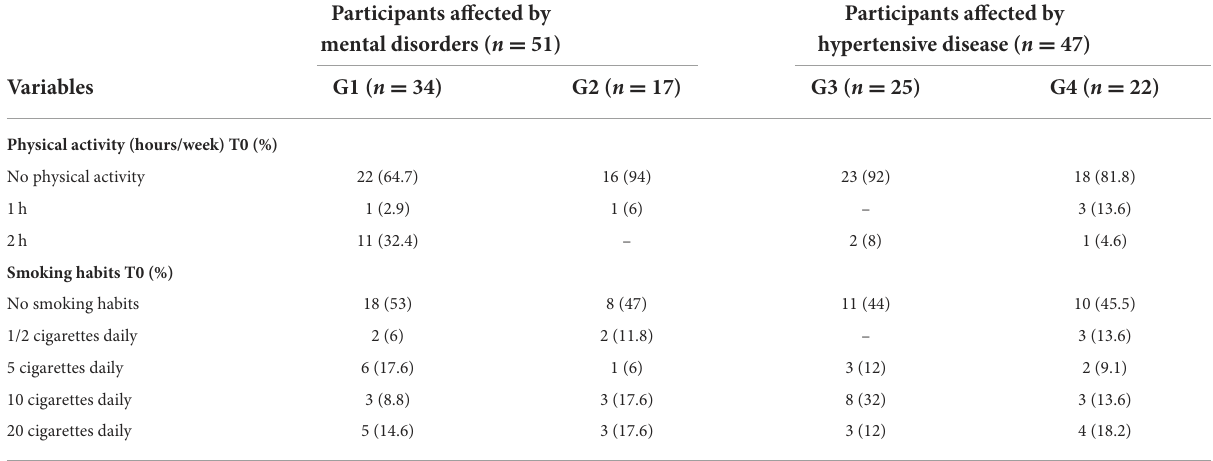
Participants affected by hypertensive disease ( n =